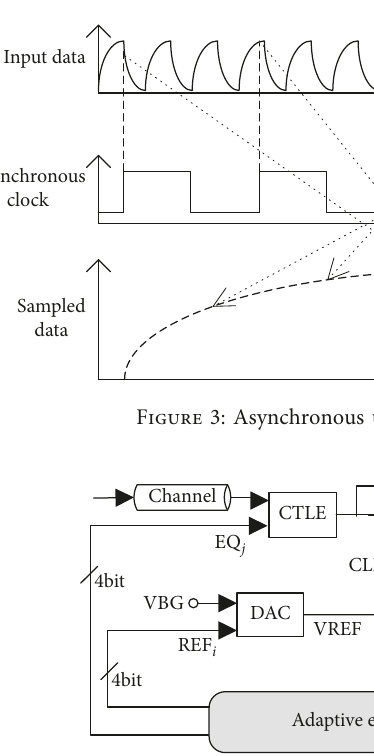
Figure 2: Eye diagrams and statistic bars. (a) Optimal equalization. (b) Over equalization.